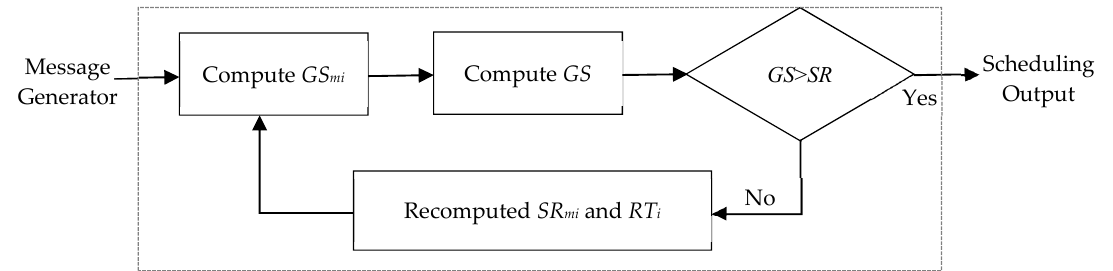
Figure 3. Flowchart of the message reliability processing module .